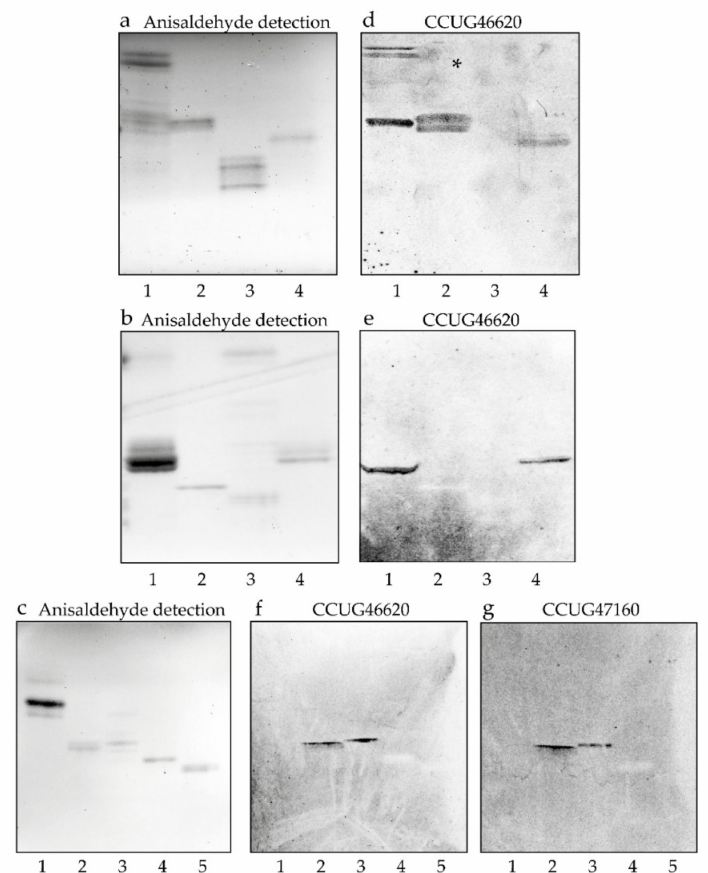
Figure 6. Binding of C. matruchotii to reference glycosphingolipids on thin-layer chromatograms. Chemical detection by anisaldehyde ( a – c ), and autoradiograms obtained by binding of C. matruchotii strain CCUG46620 ( d – f ) and C. matruchotii strain CCUG47160 ( g ), followed by autoradiography for 12 h. The solvent system used was chloroform / methanol / water (60:35:8, by volume). The lanes on ( a , d ) are: Lane 1, non-acid glycosphingolipids of rat intestine, 40 µ g; lane 2, isoglobotriaosylceramide (Gal α 3Gal β 4Glc β 1Cer), 4 µ g; lane 3, Galili pentaosylceramide (Gal α 3Gal β 4GlcNAc β 3Gal β 4Glc β 1Cer) and Galili heptaosylceramide (Gal α 3Gal β 4GlcNAc β 3Gal β 4GlcNAc β 3Gal β 4Glc β 1Cer), 4 µ g; lane 4, Gal α 3-isoglobotriaosylceramide (Gal α 3Gal α 3Gal β 4Glc β 1Cer), 4 µ g. The lanes on ( b , e ) are: Lane 1, triglycosylceramides of human meconium (globotriaosylceramide, Gal α 4Gal β 4Glc β 1Cer and lactotriaosylceramide, GlcNAc β 3Gal β 4Glc β 1Cer, mixture), 10 µ g; lane 2, H type 1 pentaosylceramide (Fuc α 2Gal β 3GlcNAc β 3Gal β 4Glc β 1Cer), 4 µ g; lane 3, non-acid glycosphingolipids of porcine intestine, 20 µ g; lane 4, lactotriaosylceramide (GlcNAc β 3Gal β 4Glc β 1Cer), 4 µ g. The lanes on ( c , f , g ) are: Lane 1, globotriaosylceramide (Gal α 4Gal β 4Glc β 1Cer), 8 µ g; lane 2, lactotetraosylceramide (Gal β 3GlcNAc β 3Gal β 4Glc β 1Cer), 4 µ g; lane 3, neolactotetraosylceramide (Gal β 4GlcNAc β 3Gal β 4Glc β 1Cer), 4 µ g; lane 4, H type 2 pentaosylceramide (Fuc α 2Gal β 4GlcNAc β 3Gal β 4Glc β 1Cer), 4 µ g; lane 5, Le x pentaosylceramide (Gal β 4(Fuc α 3)GlcNAc β 3Gal β 4Glc β 1Cer), 4 µ